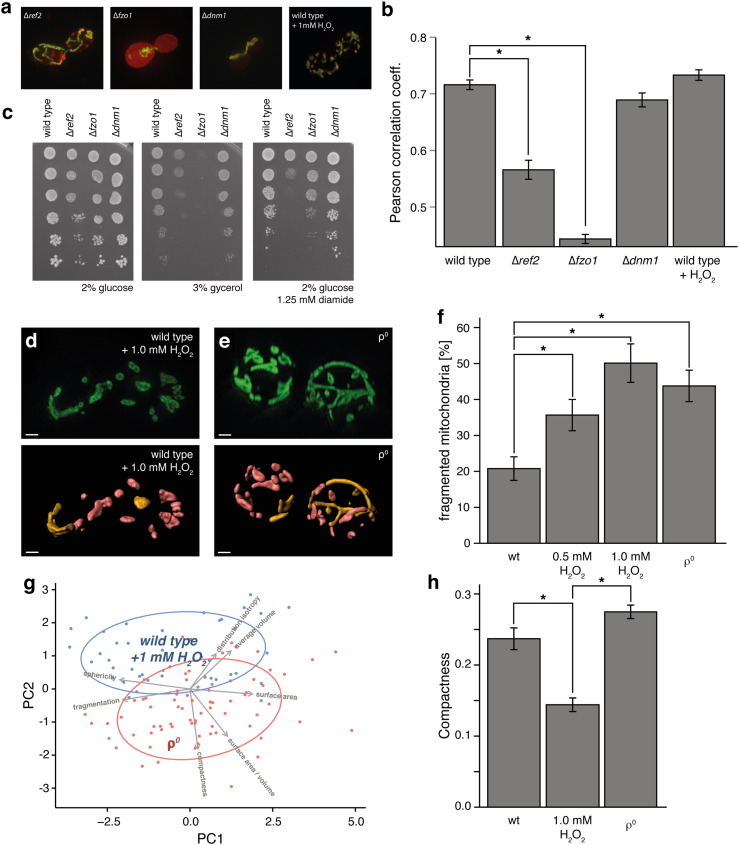
MitoLoc employed for analysis of the relationship between mitochondrial membrane potential and morphology.(a) Wide-field microscopy images of BY4741 yeast cells with deletions of mitochondrial fusion/fission factors REF2, FZO1 and DNM1, or treated with 1 mM H2O2 for 45 min. Green, preSU9-GFP; red, preCOX4-mCherry.(b) Quantification of the mitochondrial membrane potential based on co-localisation analysis. ∆ref2 and ∆fzo1 cells show reduced membrane potential. n > 87; * p < 0.01; error bars represent +/− SEM.(c) Growth on the non-fermentable carbon source glycerol (middle panel) is impaired in ∆ref2 and ∆fzo1 strains, but unaffected in ∆dnm1 yeast. Magnitude of the growth defect is correlated with MMP loss. (right panel) Resistance against 1.25 mM diamide is reduced in ∆ref2 and ∆fzo1, but comparable to wild type in ∆dnm1.(d,e) Mitochondrial network morphology in wild-type cells treated with 1 mM H2O2 for 45 min and respiratory-deficient ρ0 determined using 3D-SIM. (upper panels) PreSU9-GFP (green) image of a typical mitochondrial network. Scale bar = 1 μm. (lower panels) 3D reconstruction of the network, with individual fragments colour-coded according to their relative size. Scale bar = 1 μm.(f) Quantification of the fragmentation grade in mitochondrial networks of wild type cells treated with 0.5 or 1 mM H2O2 for 45 min and respiration-deficient ρ0 cells. n = 30; * p < 0.01; error bars +/− SEM.(g) Principal component analysis separates mitochondrial geometry of H2O2 treated and respiratory-deficient ρ0 cells as determined by preSU9-GFP and super-resolution microscopy. Separation in PC1 is mostly driven by fragmentation, while sphericity and compactness contribute to separation in PC2. n = 30 cells per genotype.(h) The MitoMap parameter representing tubularity (compactness) determined in wild type yeast cells, cells treated with 1 mM H2O2 for 45 min and respiratory-deficient ρ0 cells. n > 42; * p < 0.01; error bars represent +/− SEM.